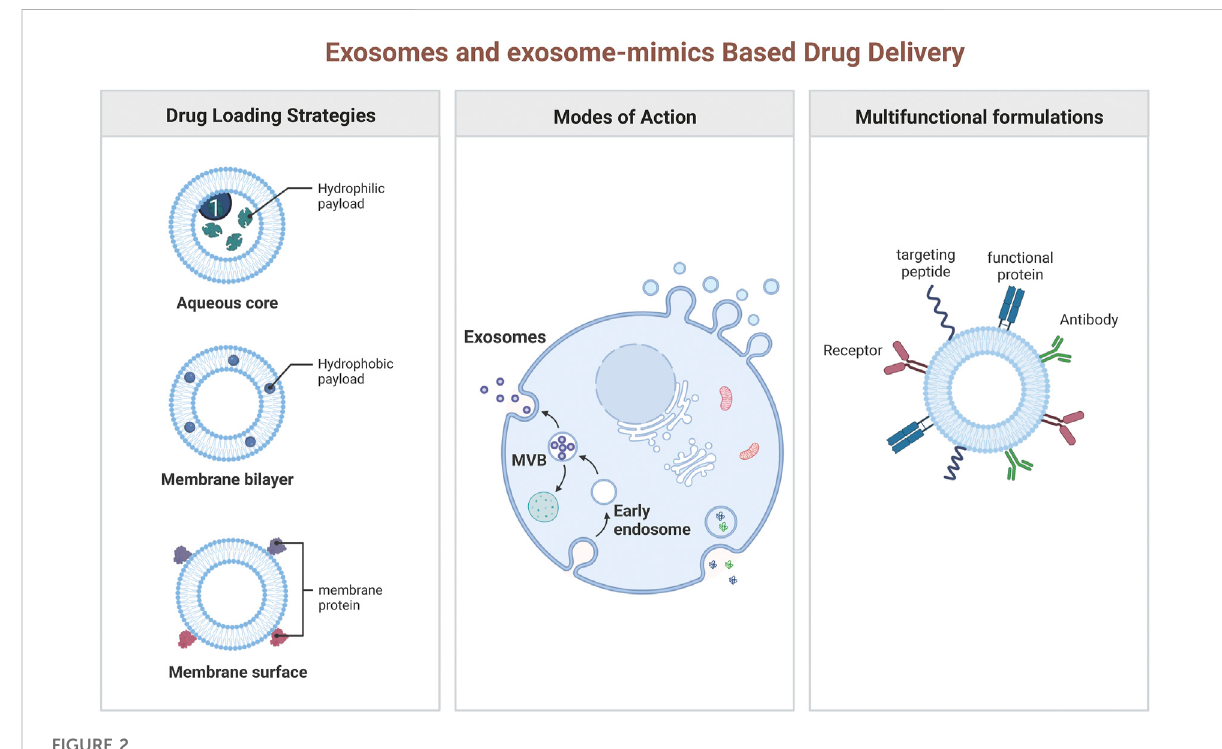
FIGURE 2 Drug loading strategies of exosomes and